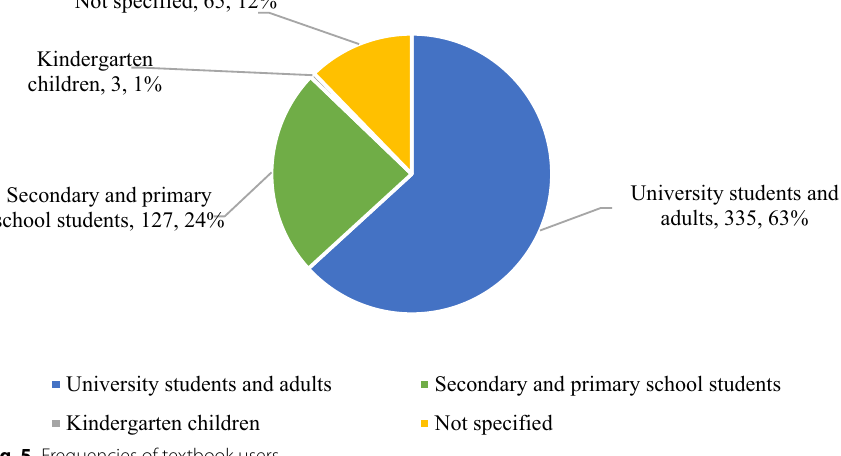
Fig. 5 Frequencies of textbook